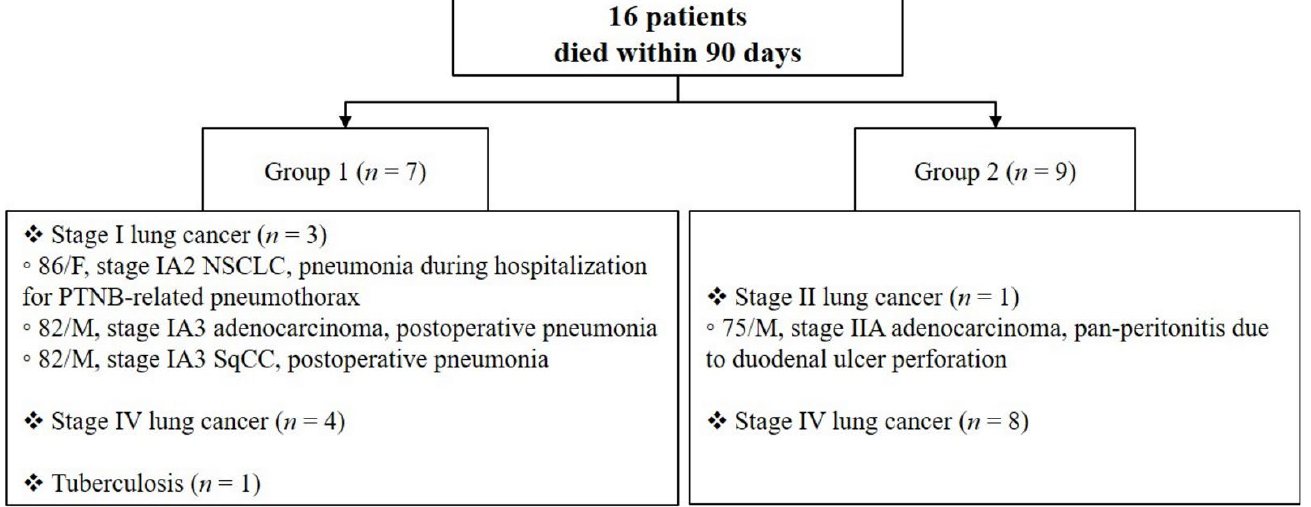
Figure 1. Detailed information of patients who died within 90 days after CT-guided PTNB. Patient 1 was an 86-year-old female with stage IA2 non-small-cell lung cancer who developed pneumonia while hospitalized for pneumothorax care after PTNB. She expired 49 days after PTNB and did not receive any treatment for lung cancer. She was a nonsmoker, but had emphysema, idiopathic pulmonary fibrosis (IPF), diabetes mellitus (DM), chronic hepatitis C, and chronic kidney disease. Patient 2 was an 82-year-old male with stage IA3 adenocarcinoma. He underwent lobectomy and developed pneumonia during postoperative management. He died 52 days after PTNB and 32 days after the surgery. A 50 pack-year former smoker, patient 2 also had emphysema, early IPF, and hypertension. Patient 3 was an 82-year-old male with stage IA3 squamous cell carcinoma. He received a wedge resection and was rehospitalized for pneumonia the day following his discharge from surgery. He died 77 days after PTNB and 63 days after the surgery. He was a 200 pack-year former smoker with emphysema, early IPF, coronary artery disease, DM, hypertension, Alzheimer’s disease, and liver cirrhosis. Patient 4 was a 75-year-old male with stage IIA adenocarcinoma and underwent lobectomy immediately after PTNB, along with adjuvant chemotherapy. He was admitted to the emergency room for duodenal ulcer perforation and pan-peritonitis and died of multiorgan failure 83 days after PTNB. He was a 40 pack-year former smoker and had emphysema, a history of ST-elevation myocardial infarction, hypertension, DM, and chronic kidney disease.